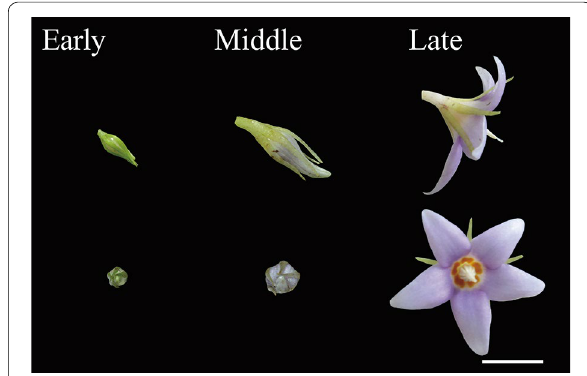
Fig. 1 The flower of C. ramondioides from early to late stage. Early, middle and late stage corresponding to Stage 10, 13, 15 in Additional file 1: Table S1. Actinomorphy was observed in late stage C. ramondioides flower. Scale bar represented 1